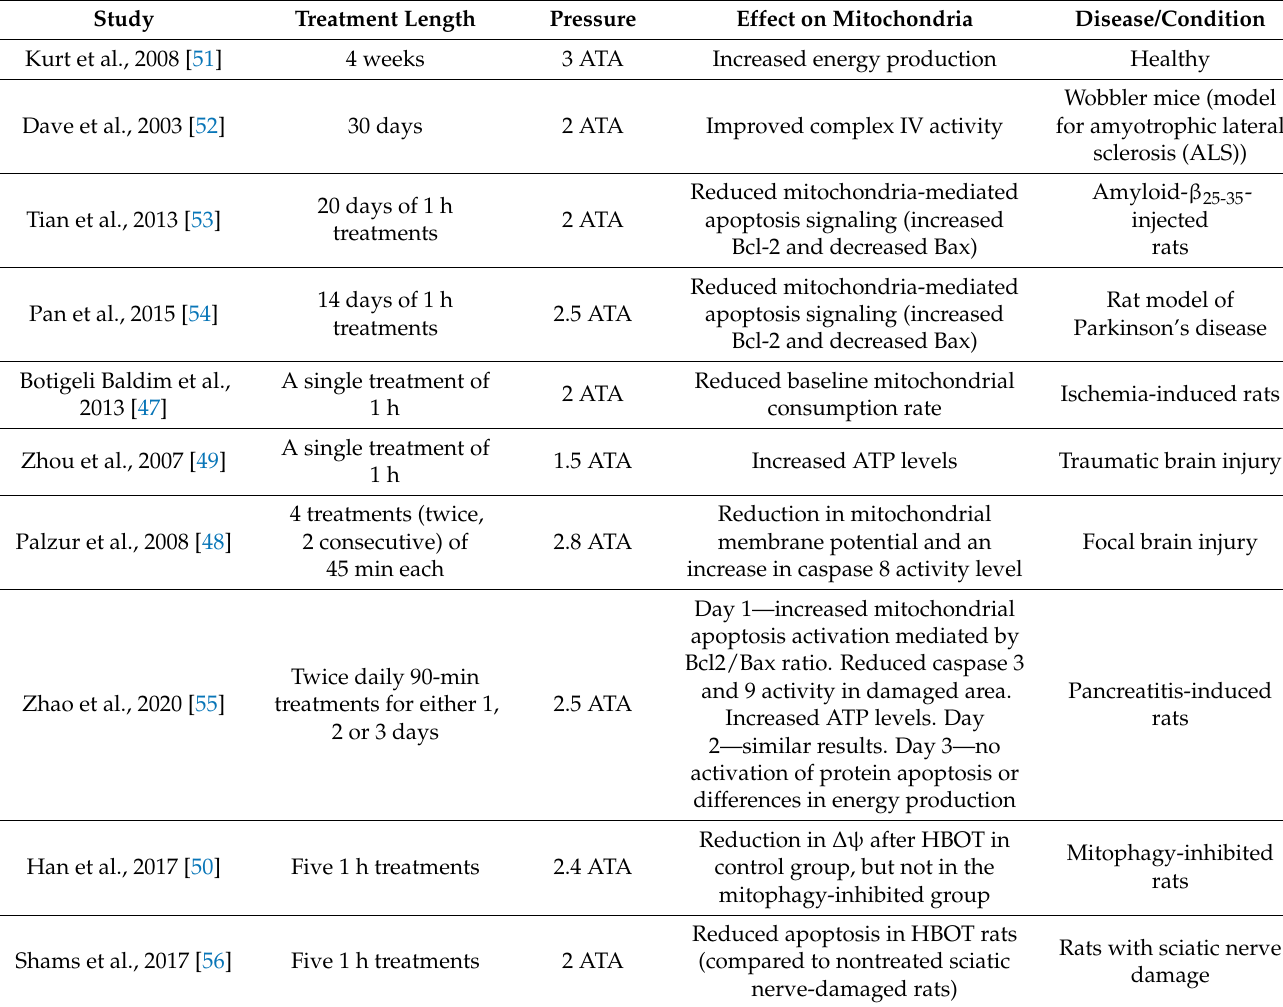
Table 1. Effects of HBOT on mitochondrial activity in different pathologies and